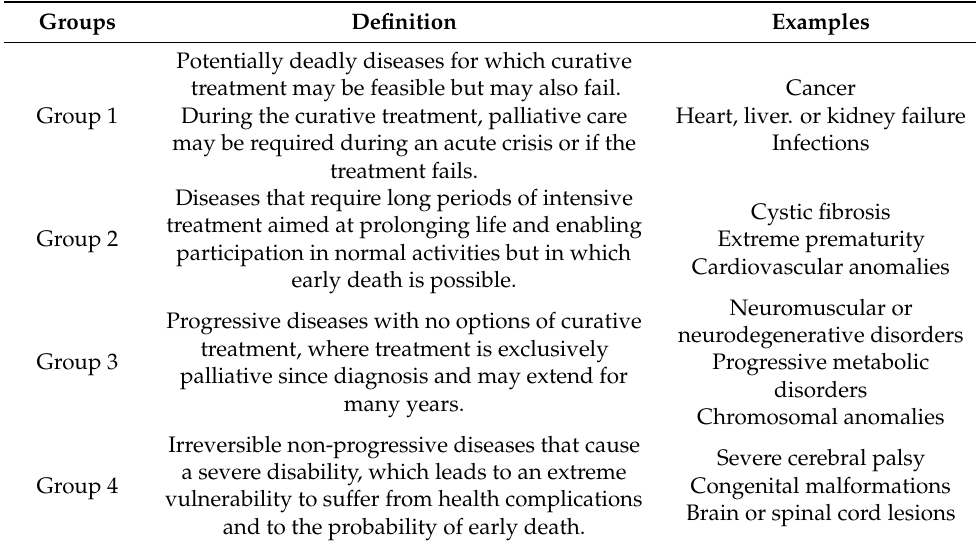
Table 1. Classification of the ACT and RCPCH regarding patients susceptible to receive PPC